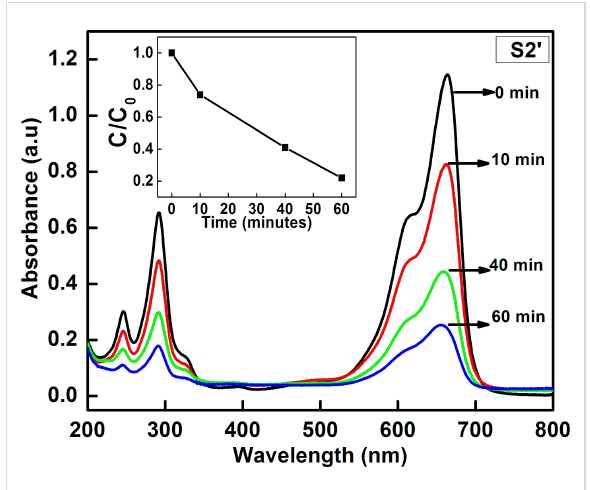
Figure 7: UV–vis absorption spectra showing photocatalytic degrad- ation of 10 μ M MB upon irradiation with sun light using aged sample S2’ as photocatalyst. Inset shows the variation of MB concentration with exposure